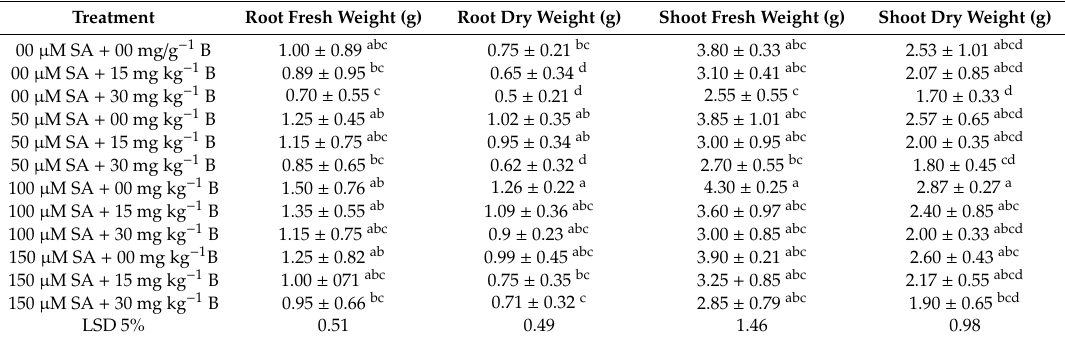
Table 2. E ff ect of SA (0, 50, 100 and 150 µ M) on the plant fresh and dry weight of maize cultivar Gohar-19 under varying B toxicity levels (0, 15 and 30 mg kg − 1 ).